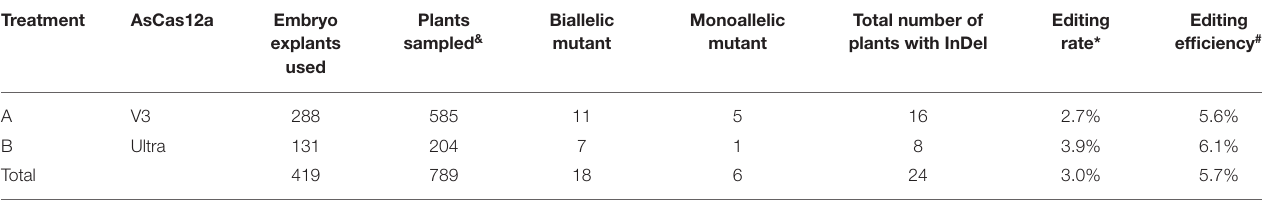
TABLE 4 | Mutation frequency of Bx9TS2 target in E0 plants directly generated from bombarded immature embryos with RNP without selection.